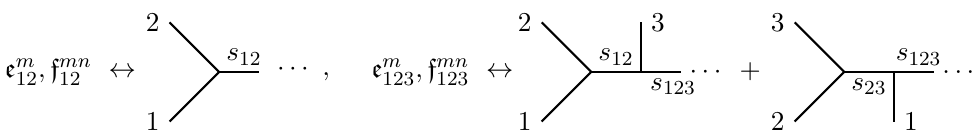
Figure 6 . Cubic-vertex subdiagrams with an o(cid:11)-shell captured by Berends-Giele currents e m